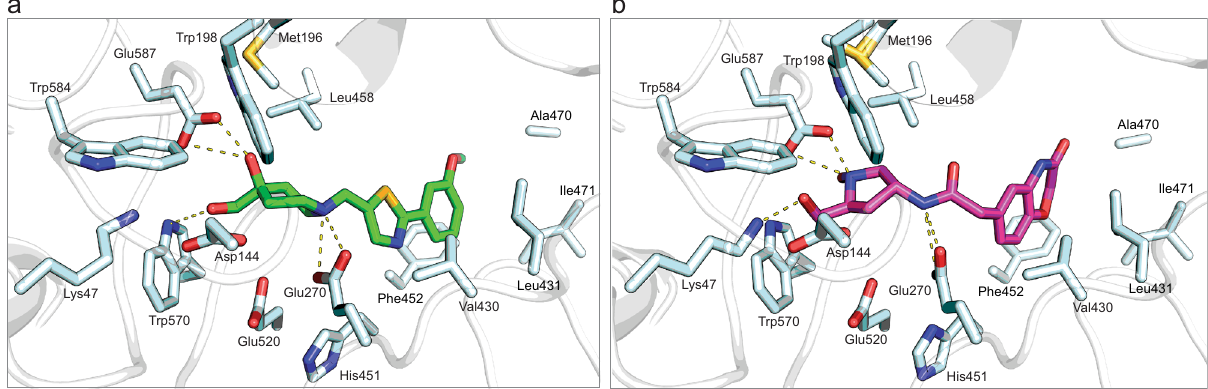
Fig. 7 Hit 1 and Hit 9 bind within the active site of Cryptococcus neoformans ( Cn ) Sgl1. a Co-crystal structures of Hit 1 (green) and b Hit 9 (magenta) in the active site of Cn Sgl1. Hit 1 makes hydrogen bond contacts to Glu270 and Trp570. Hit 9 makes hydrogen bond contacts with Lys47, Glu270, and